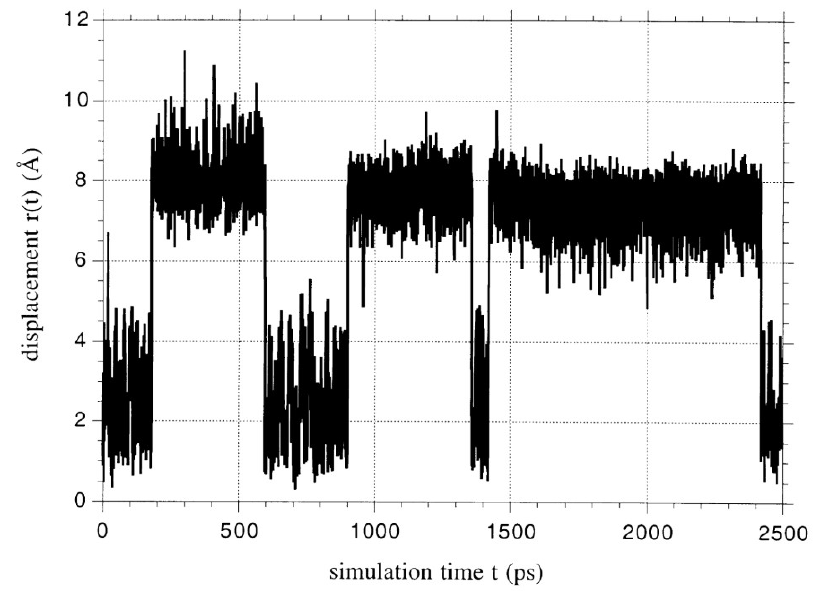
Figure 19. Displacement of an O 2 molecule in a glassy polyimide during an MD simulation: the molecule jumps back and forth between two adjacent cavities and fluctuates within a cavity in- between jumps. Reprinted with permission from Ref. [329]. Copyright 2000, Elsevier.